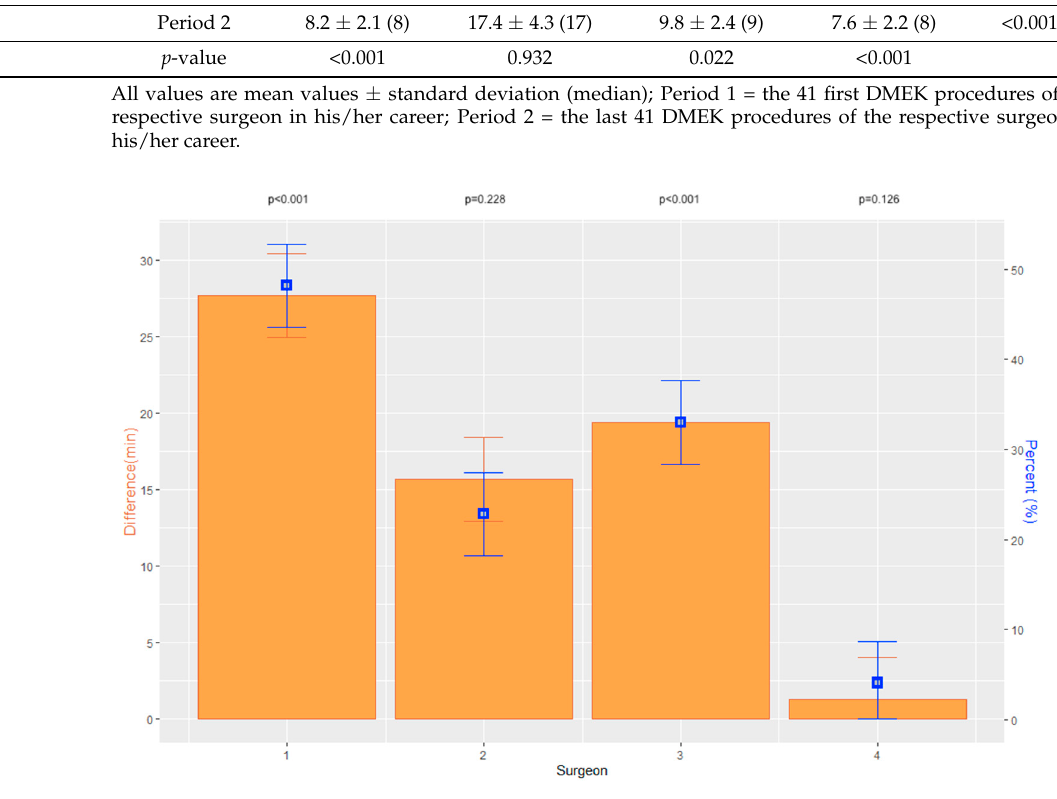
Figure 2. Graphs displaying absolute difference of surgical duration of DMEK of each surgeon be- tween period 1 and 2 in minutes, including the standard error and p -values as well as the percentage difference for each surgeon. Table 2. Surgical data.